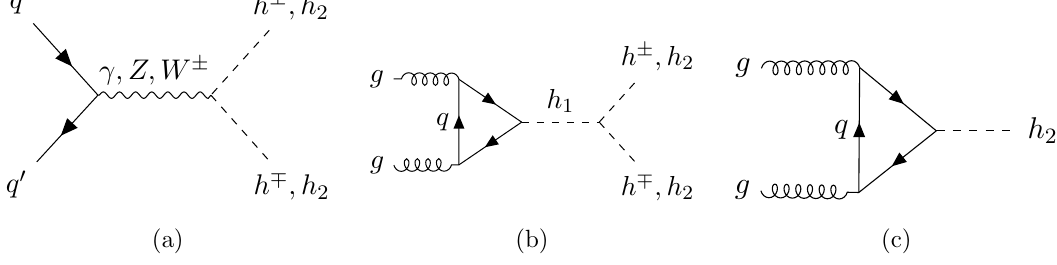
Figure 6. Feynman diagrams showing the primary production processes for the new scalars, including Drell-Yan pair production (a), pair production via an intermediate o(cid:11)-shell h 1 (b), and single h 2 production via gg F